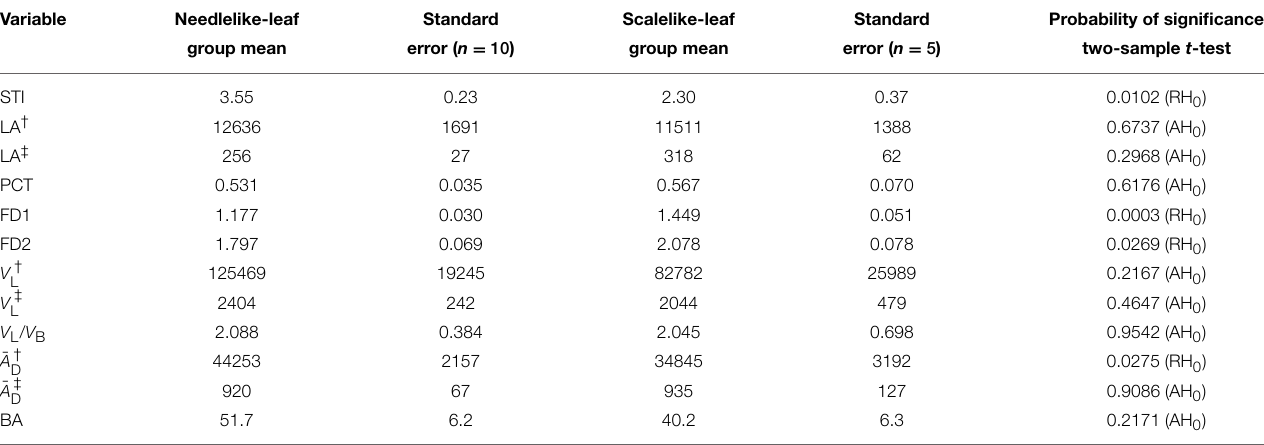
TABLE 3 | Group means depending on leaf type and corresponding standard errors for the shade tolerance index and the crown traits that were measured from CT scanning data and CT images for both groups of miniature conifers, together with the result of the statistical comparison of the two means per variable (AH 0 , Accept the null hypothesis of equality of means; RH 0 , Reject, at 5%).